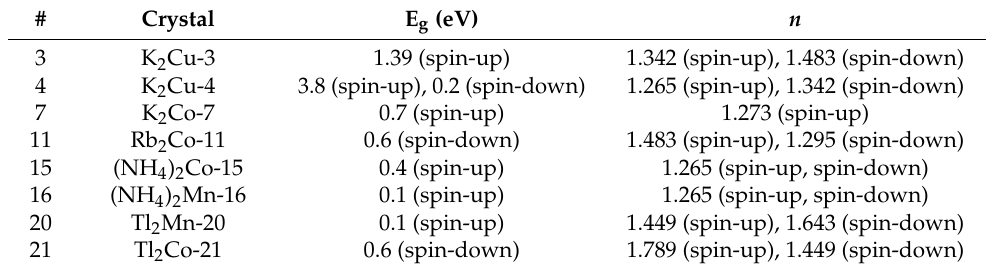
Table 4. Calculated spin-up and spin-down energy gap and refractive